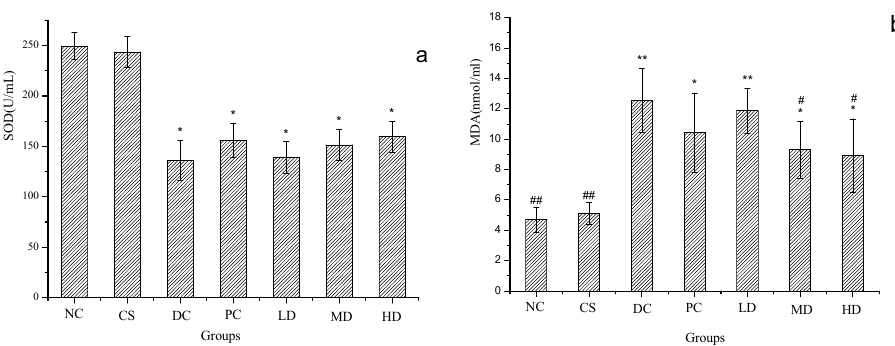
Figure 5. SOD ( a ) and MDA ( b ) of normal and STZ induced diabetic mice. Results were presented as means ± SD ( n = 10). The columns of each index have * p < 0.05, ** p < 0.01 vs. NC; # p < 0.05, ## p < 0.01 vs. DC. Group abbreviations are as given in the caption of Figure 1.